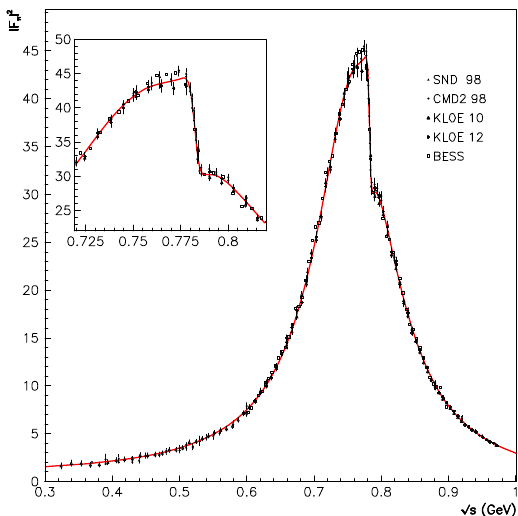
Fig. 1 The HLS model at work. The left panel shows the global HLS model fit of the ππ channel together with the data from Novosibirsk, Frascati and Beijing. The right panel shows the P -wave π + π − phase-